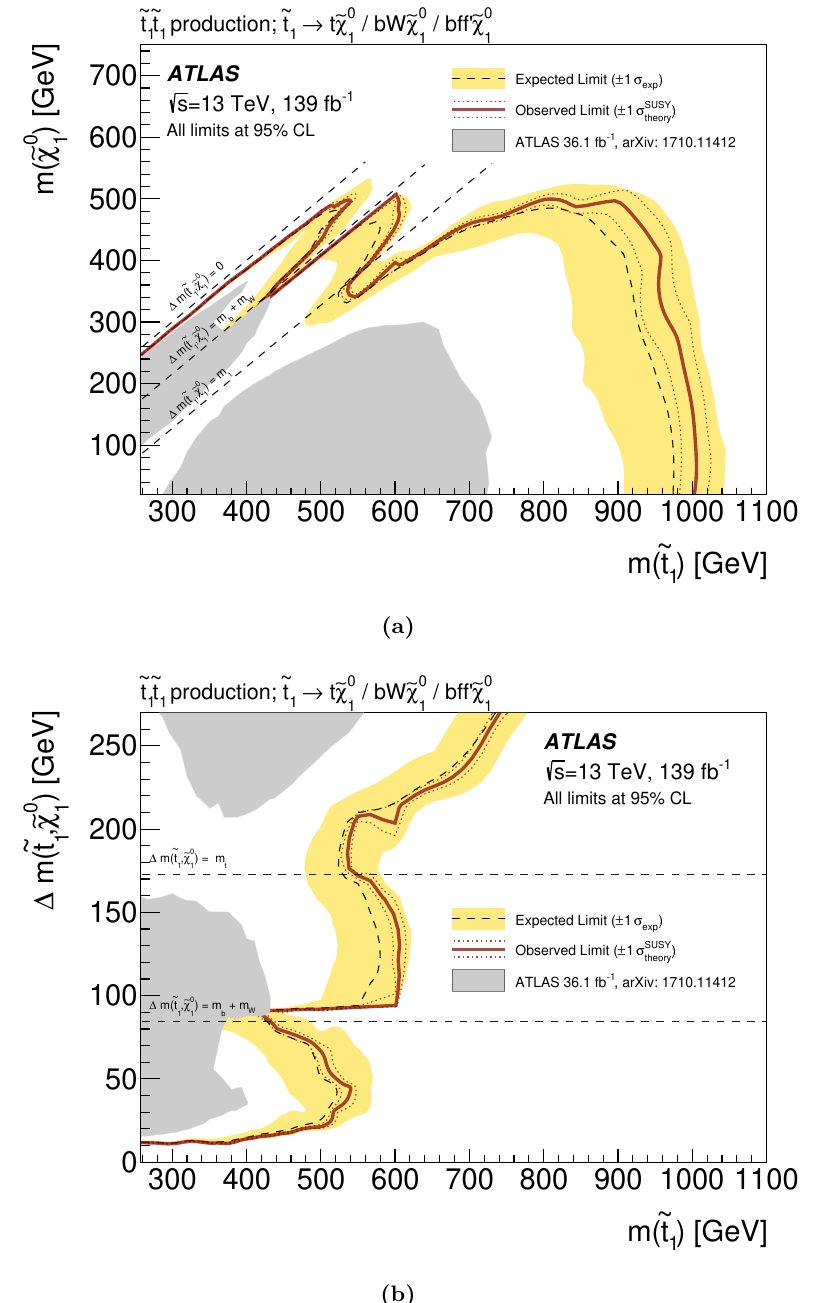
Figure 14 . Exclusion limit contour (95% CL) for a simplified model assuming ˜ t 0 decaying via ˜ t → t ( ∗ ) ˜ χ 1 with 100% branching ratio, in the (a) m 1 0 ∆ m (˜ t , ˜ χ 1 ) planes. The dashed lines and the shaded bands are the expected limits and their ± 1 σ 1 uncertainties. The thick solid lines are the observed limits for the central value of the signal cross- section. The expected and observed limits do not include the effect of the theoretical uncertainties in the signal cross-section. The dotted lines show the effect on the observed limit when varying the signal cross-section by ± 1 σ of the theoretical